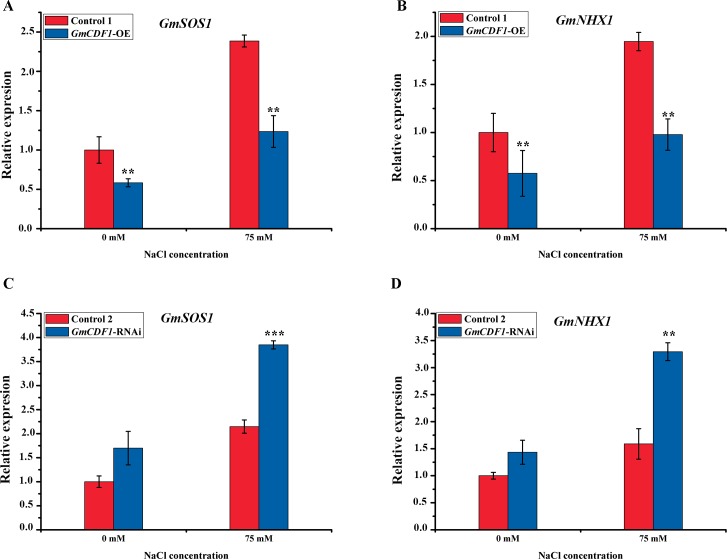
Relative expression levels of GmSOS1 and GmNHX1 in soybean hairy roots.(A) Relative expression levels of GmSOS1 in Control 1 and GmCDF1-OE hairy roots after treatment with normal or salt conditions for four days. The data are presented as the means±SEs (n≥3). Statistical significance was detected by a two-tailed t-test. (B) Relative expression levels of GmNHX1 in Control 1 and GmCDF1-OE hairy roots after treatment with normal or salt conditions for four days. The values are the means±SEs (n≥3). Statistical significance was detected by a two-tailed t-test. (C) Relative expression levels of GmSOS1 in Control 2 and GmCDF1-RNAi hairy roots after treatment with normal or salt conditions for four days. The data are presented as the means±SEs (n≥3). Statistical significance was detected by a two-tailed t-test. (D) Relative expression levels of GmNHX1 in Control 2 and GmCDF1-RNAi hairy roots after treatment with normal or salt conditions for four days. The data are presented as the means±SEs (n≥3). Statistical significance was detected by a two-tailed t-test. (*P<0.05, **P<0.01, ***P<0.001).